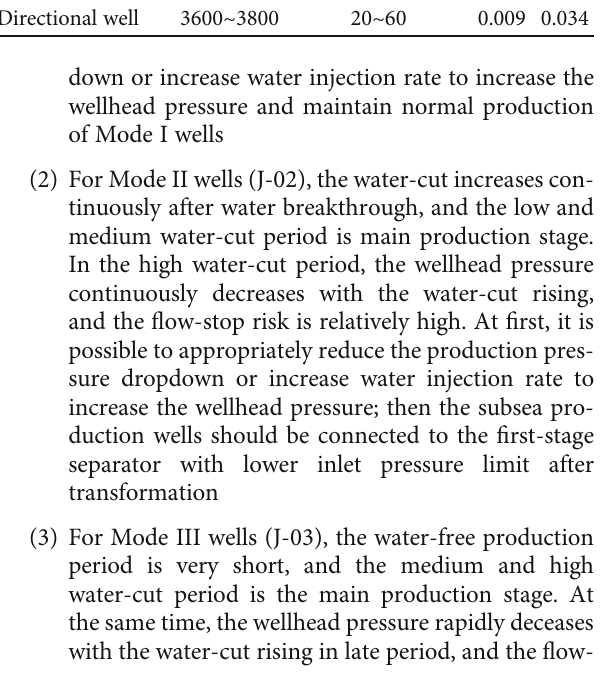
Table 6: The parameters e